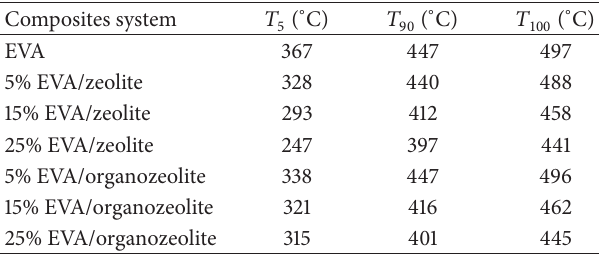
Table 2: TGA results of EVA matrix and its